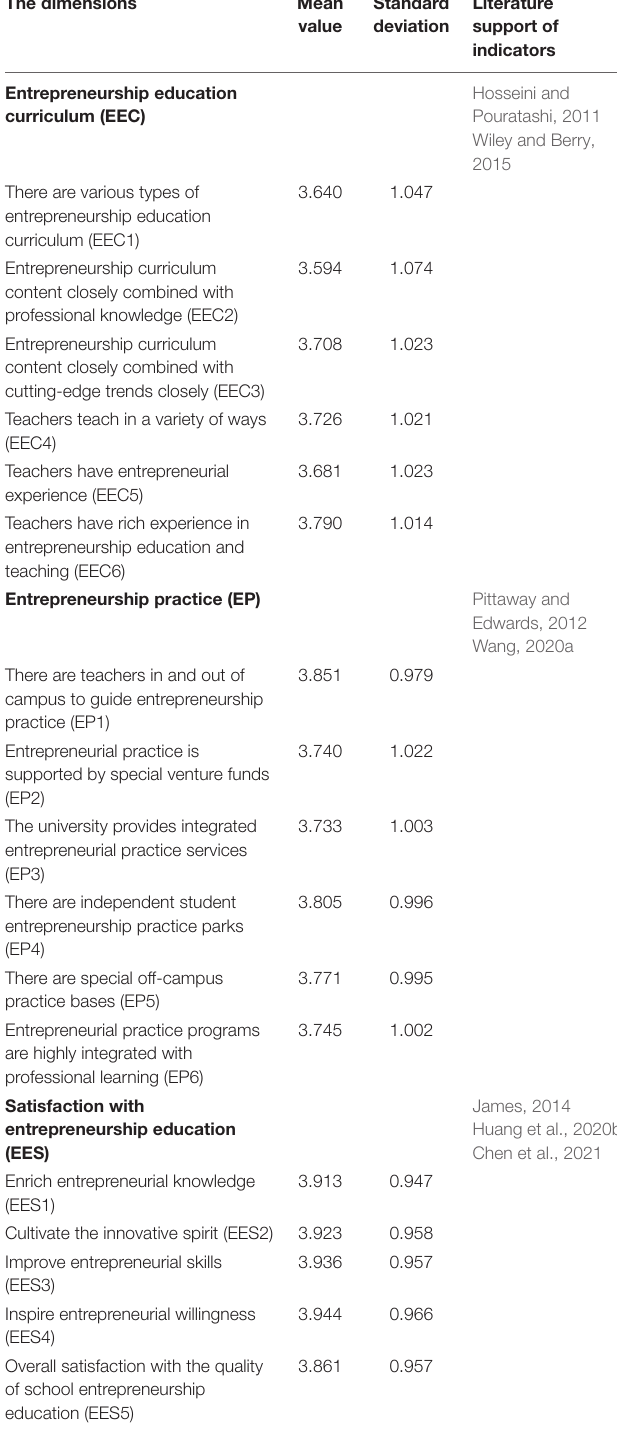
TABLE 4 | The dimensions of students’ entrepreneurship education in